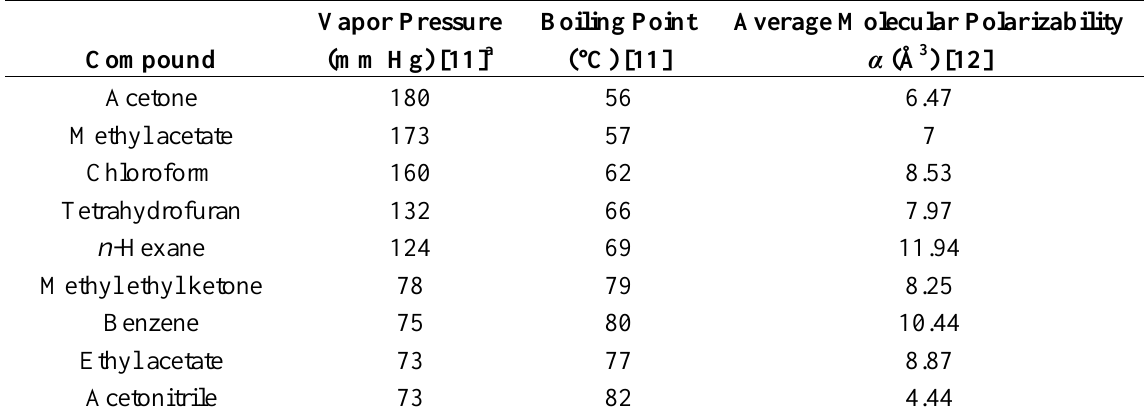
Table 1. Vapors and their properties used in the current